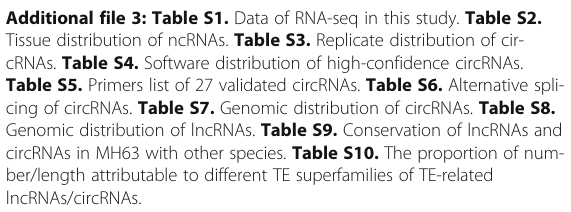
cRNAs. Table S4. Software distribution of high-confidence circRNAs. Table S5. Primers list of 27 validated circRNAs. Table S6. Alternative spli- cing of circRNAs. Table S7. Genomic distribution of circRNAs. Table S8. Genomic distribution of lncRNAs. Table S9. Conservation of lncRNAs and circRNAs in MH63 with other species. Table S10. The proportion of num- ber/length attributable to different TE superfamilies of TE-related